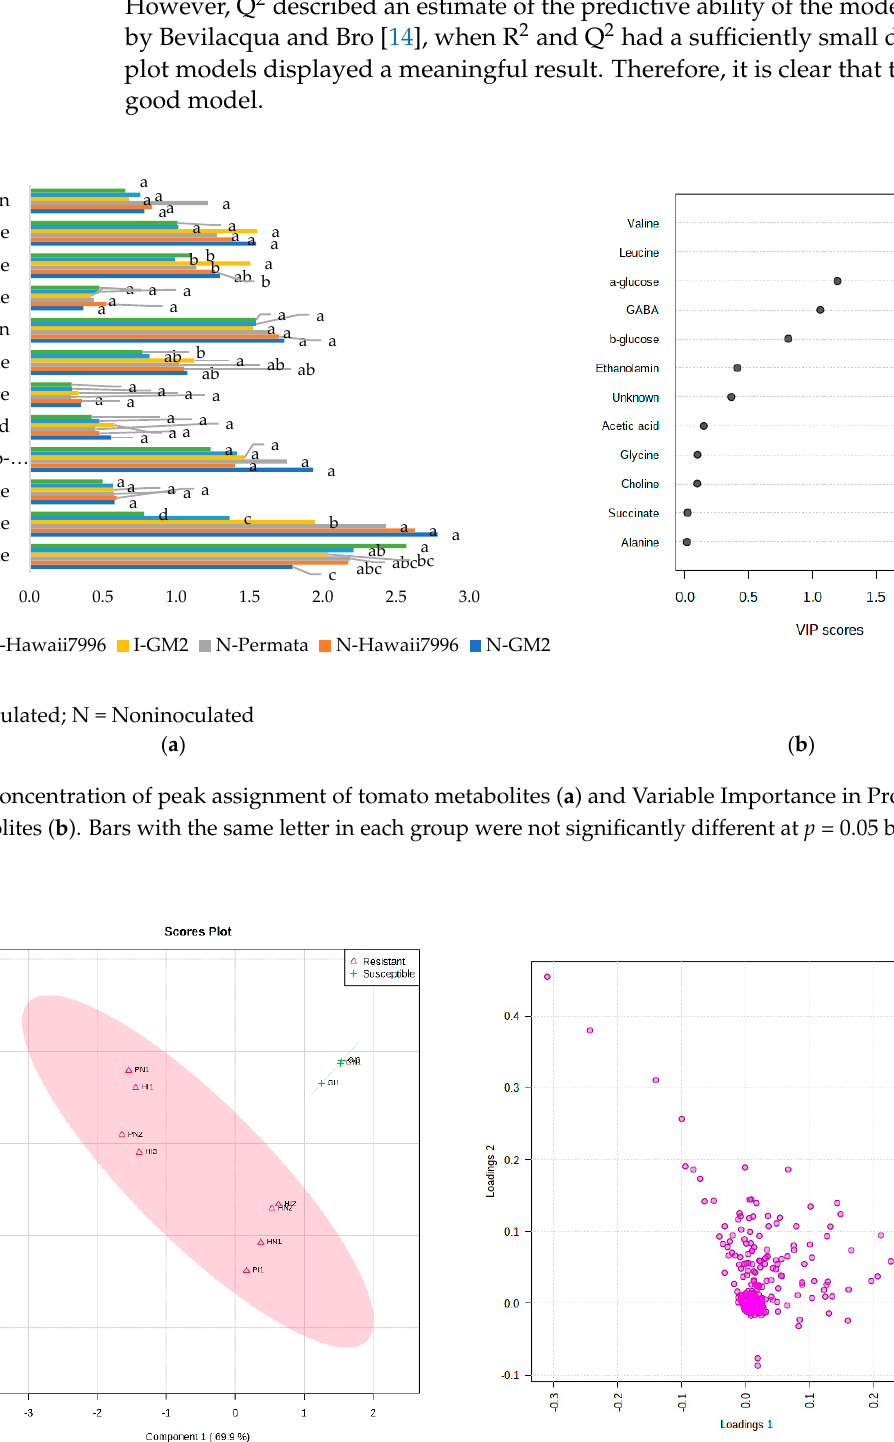
( b ) Figure 5. Validation of the PLS-DA model showing the variance of the response and predictive ability of the model ( a ) and a permutation test statistic ( b ). (*) indicates the optimal number of components included in order to make this model work.